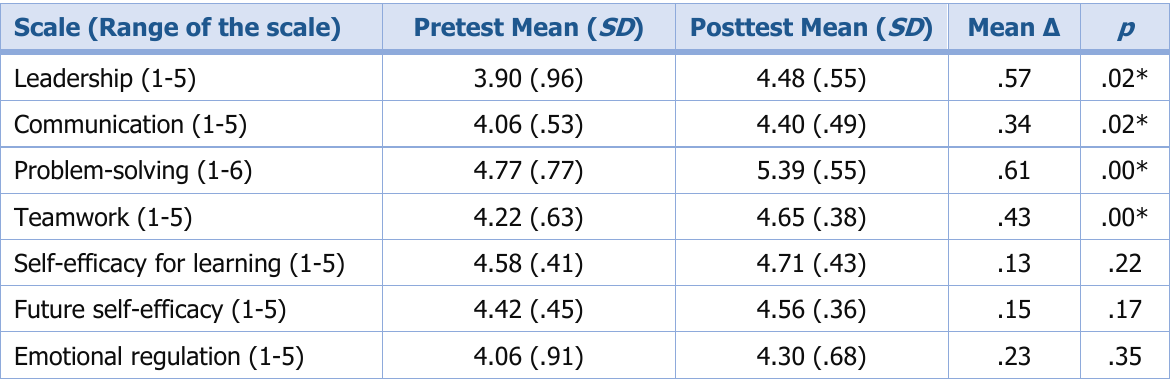
Table 3. Program Outcomes From Pre-Program and Post-Program Surveys (N = 19) Scale (Range of the